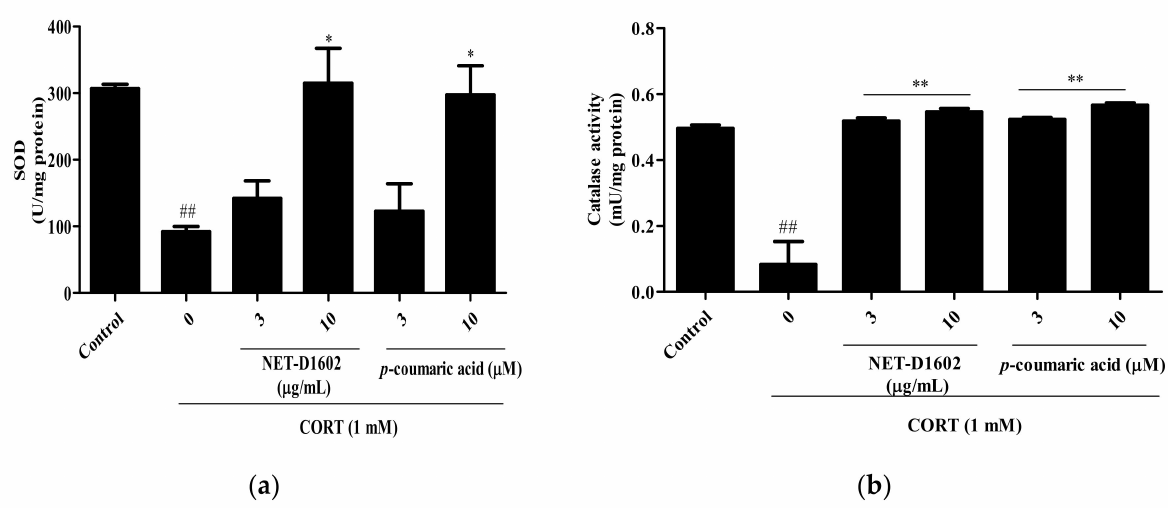
Figure 4. Effects of NET-D1602 and p -coumaric acid on ( a ) SOD and ( b ) catalase activities against CORT-induced death in SH-SY5Y cells. SH-SY5Y cells were pretreated with the indicated concentrations of NET-D1602 and p -coumaric acid for 6 h and subsequently treated with CORT (1 mM) for 24 h. The values are expressed as the mean ± standard error of the mean (n = 3). ## p < 0.01 compared to that of the untreated group; * p < 0.05 and ** p < 0.01 compared to that of the CORT group. CORT, corticosterone; SOD, superoxide dismutase; NET-D1602, HP-20 resin fraction of the water extract of Vaccinium bracteatum